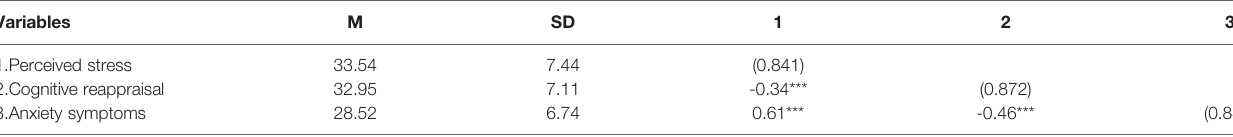
TABLE 2 | Intercorrelations and descriptive statistics between variables.